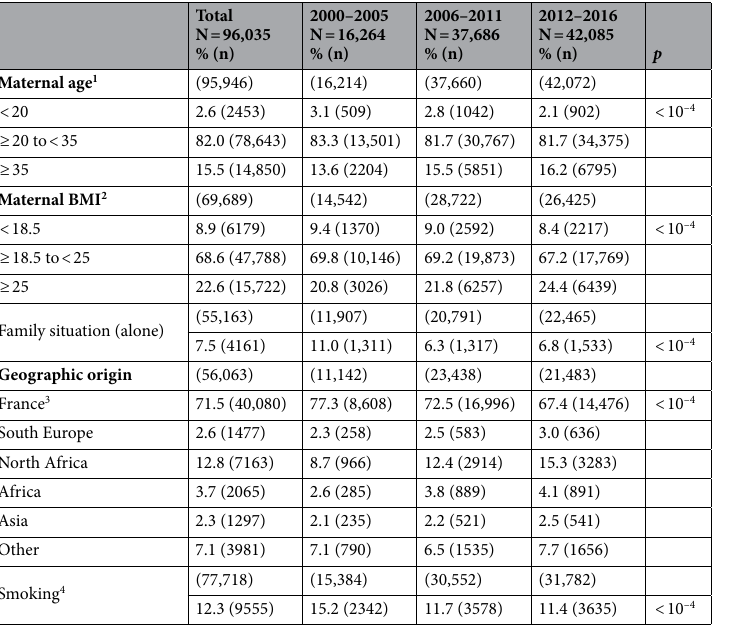
Table 1. Description of social and demographic characteristics of the overall cohort and according to the 3 studied periods. For each outcome, the first line reports the number of cases with available data/ 1 In years. 2 BMI body mass index just before the beginning of pregnancy. 3 France: Continental (metropolitan) France. 4 Tobacco during